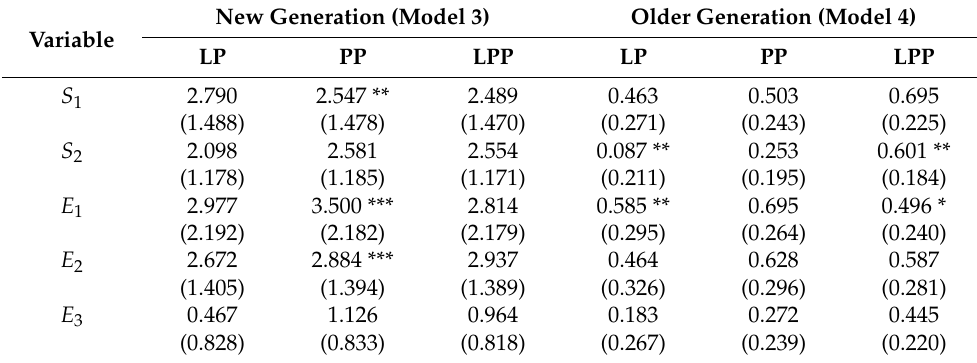
Table 4. Analysis of intergenerational